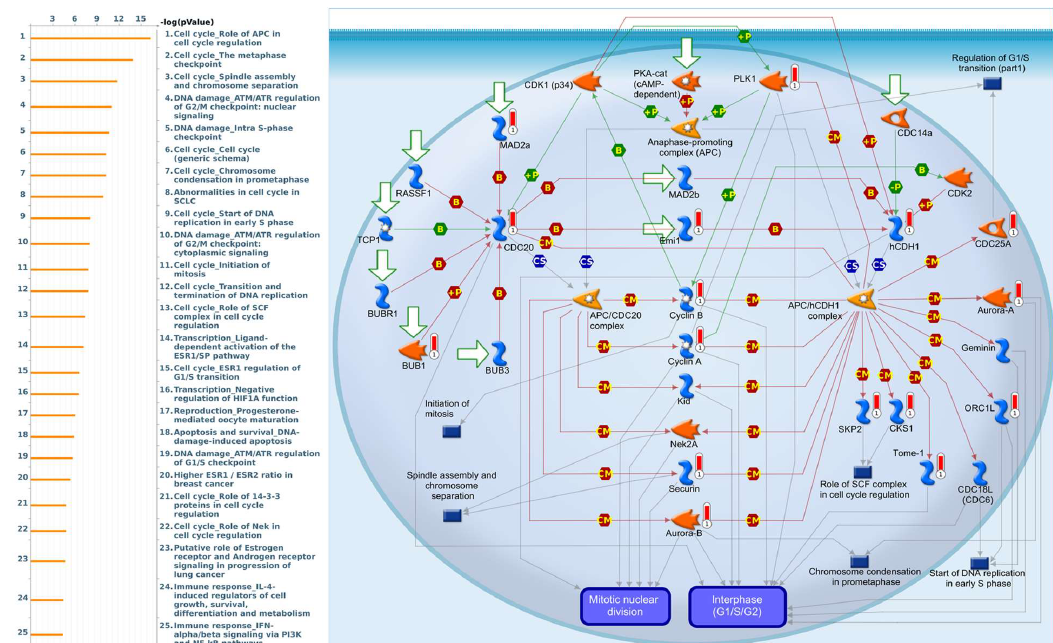
Figure 10. MetaCore pathway analysis of the coexpression gene network of proteasome 20S subunit alpha 6 (PSMA6) in breast cancer patients. We used the MetaCore platform to analyze genes coexpressed with PSMA6 from the associated METABRIC and TCGA datasets, and downstream pathway analyses revealed that “Apoptosis and survival_Regulation of apoptosis by mitochondrial proteins” participates in breast cancer development.